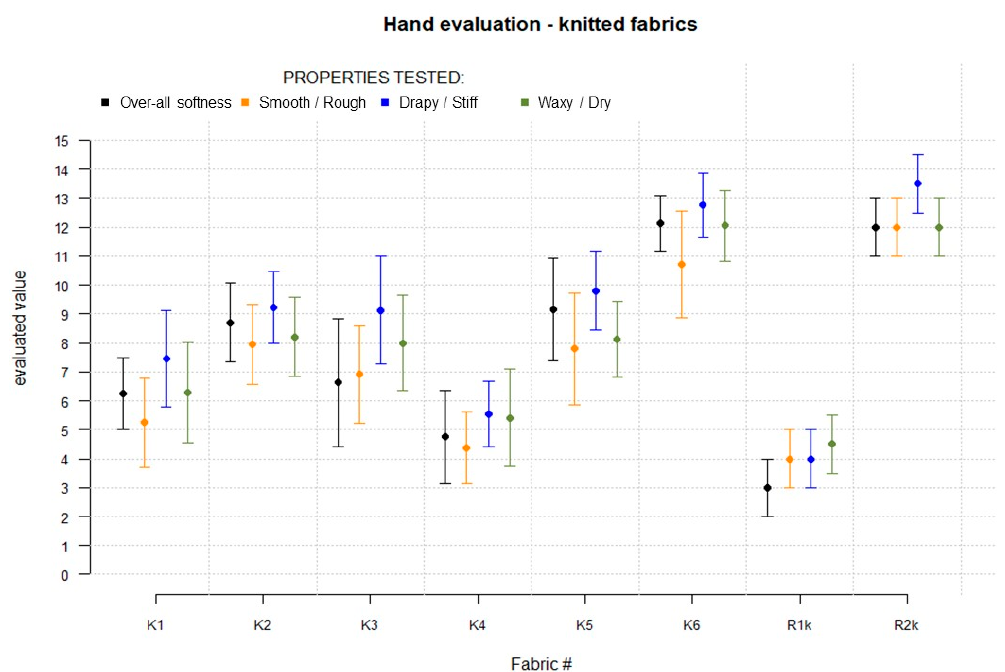
Figure 4. Average results and SD for each knitted fabric and each property.